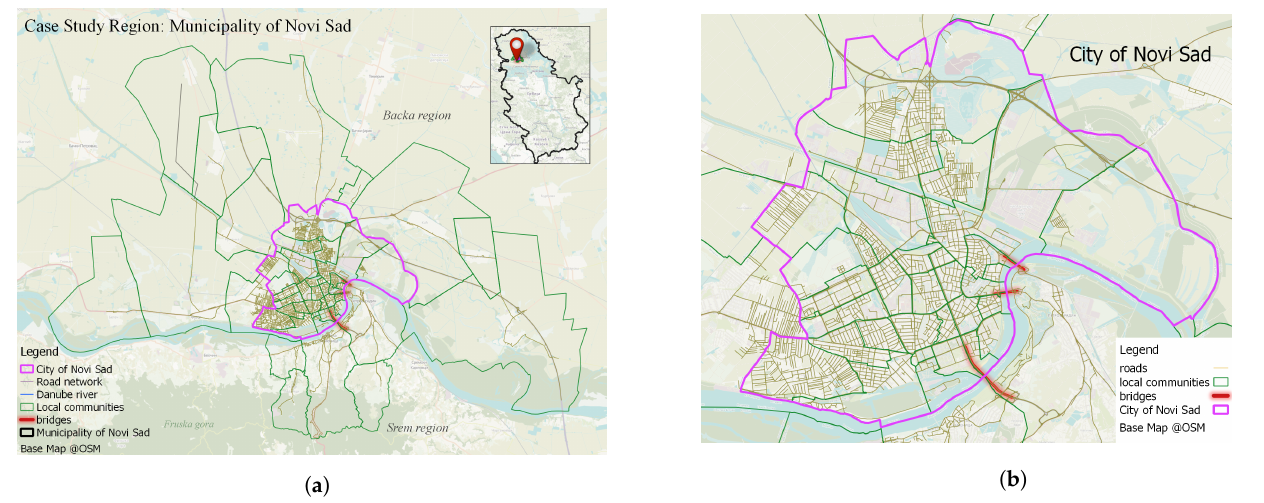
Figure 2. Case study area. ( a ) The municipality of Novi Sad is shown with its local communities. In the Figure, the city of Novi Sad (marked with pink polygon) can be distinguished from suburban areas which were included with its main roads to model traffic pressure in the city. ( b ) The city of Novi Sad, shown with its local communities and existing